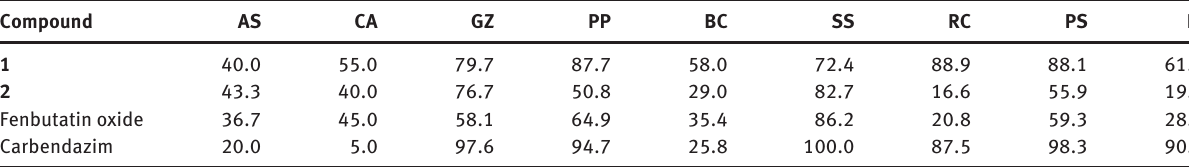
Table 2: Growth inhibition rate of the title compound to different fungi (%) at 50 μ g/mL. Compound